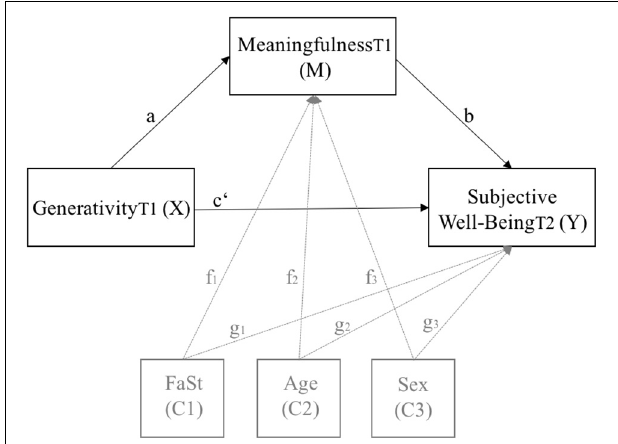
FIGURE 1 | Statistical diagram of the simple mediation model with subjective well-being as dependent variable ( Y ), generativity as independent variable ( X ), and meaningfulness as mediator ( M ) while controlling for family status (C1), age (C2), and gender